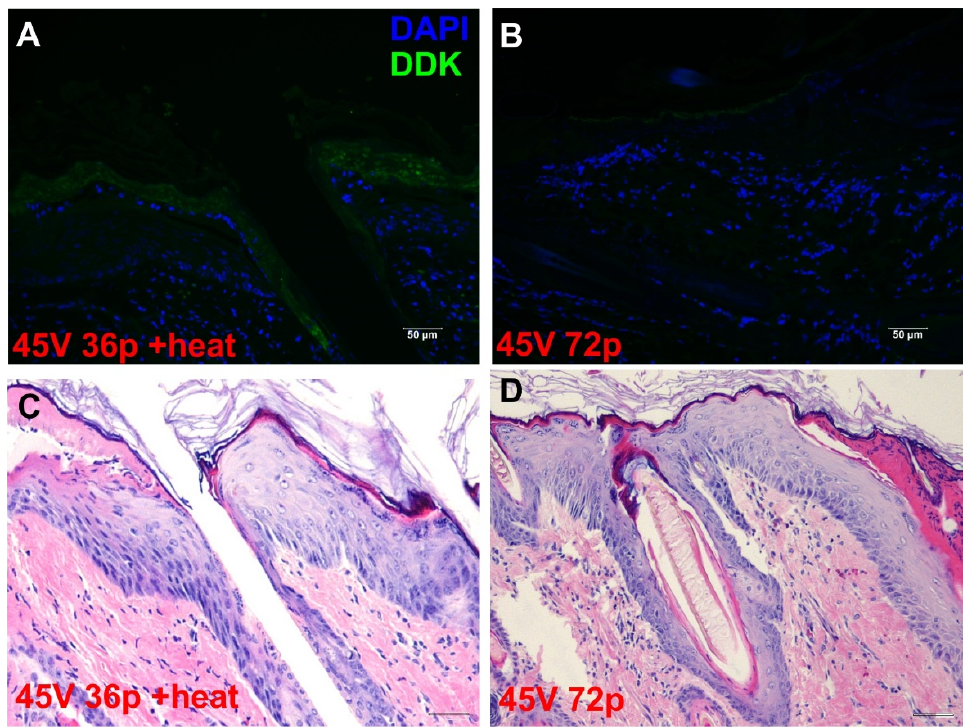
Figure 6. Expression distribution in epidermis after moderate heat-assisted GET to the skin using gWizLuc-myc-DDK. Images are representative of 3–4 individual sites. Epidermal DDK expression is shown in groups ( A ) injection of pDNA followed by 36 pulses at 45 V after the application of moderate heat (45 V 36p + heat) and ( B ) injection of pDNA followed by 72 pulses at 35 V at ambient temperature. 200×, scale bar = 50 μ m. Corresponding H&E staining of epidermis for 45 V 36p + heat ( C ) and 45 V 72p without heat ( D ); 200× scale bar = 50 μ m.